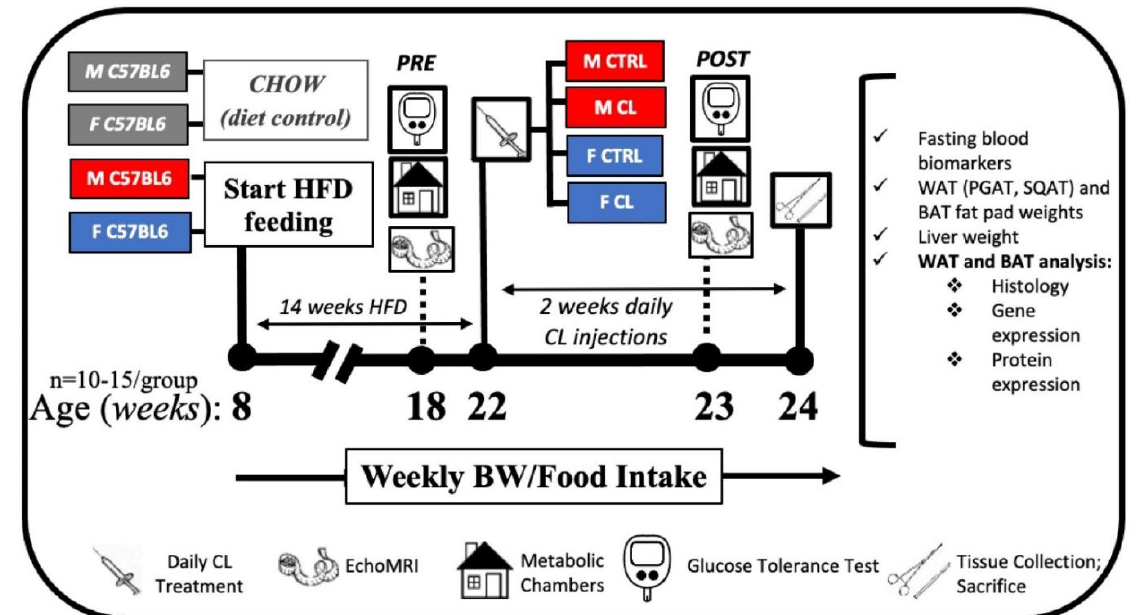
Figure 1. At 8 weeks of age, male (M) and female (F) C57BL/6J mice were fed standard rodent chow (CHOW) or a high-fat diet (HFD). HFD-fed mice were allowed ad libitum diet for 14 weeks in order to induce obesity before being randomized to control (CTRL) or CL treatments, creating the 4 experimental groups: M-CTRL, M-CL, F-CTRL, F-CL. The CHOW-fed male and female mice were used as a control for HFD-feeding to validate that HFD-induced obesity occurred. CHOW mice did not undergo treatments. Following obesity induction, the groups were assessed for body composition (EchoMRI), energy expenditure and physical activity (metabolic chambers), and glucose tolerance testing (GTT). Following this “PRE” testing, mice in the CL groups received daily CL316,243 injections for two weeks and mice in the CTRL groups received daily saline injections, during which time HFD feeding continued (i.e., HFD lasted for a total of 16 weeks). Prior to sacrifice, during the last week of the intervention, “POST” testing was performed prior to sacrifice. At sacrifice, blood biomarkers were measured and perigonadal (PGAT), subcutaneous (SQAT) and brown (BAT) adipose tissue depots, and whole livers, were collected and weighed. In addition, mean adipocyte cell size was measured for each fat depot. Protein expression (via western blotting) and mRNA expression (via qRT-PCR) were performed to assess depot and sex-specific responses to CL treatment.